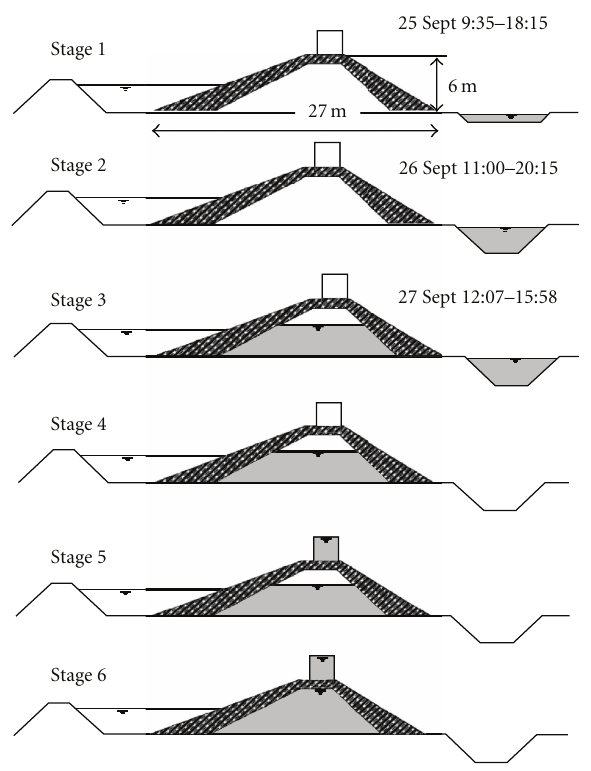
Figure 11: Six stages of loading sequence.